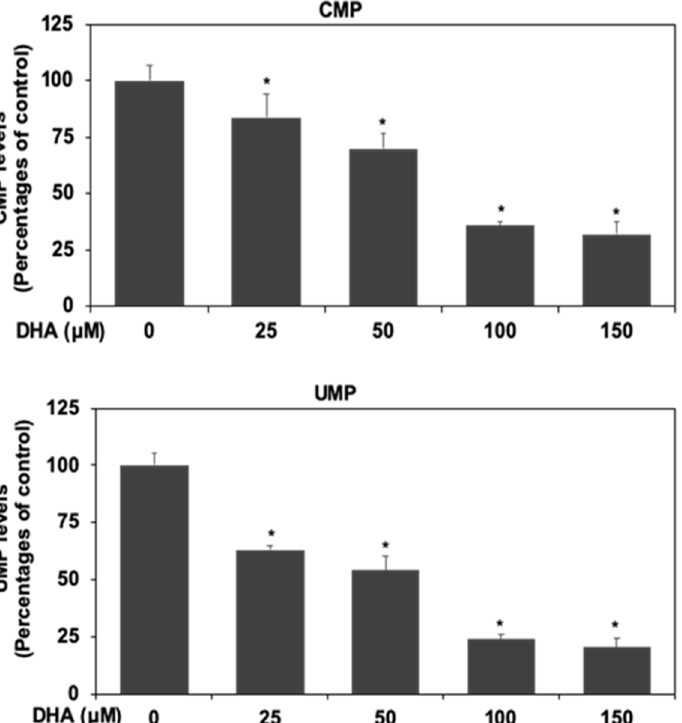
Figure 6. DHA inhibited nucleotide synthesis in HPAF-II cells. Human PDAC HPAF-II cells were treated with DHA at different concentrations in 10% FBS DMEM for 24 h. Cellular levels of CMP and UMP were measured by using LC- MS system as described in Material and Methods Section. An asterisk (*) represents statistically significant differences in comparison with the control subgroup ( p < 0.05).